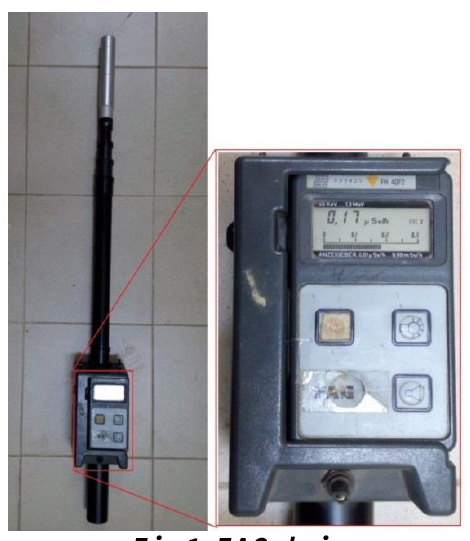
Fig. 1: FAG device.